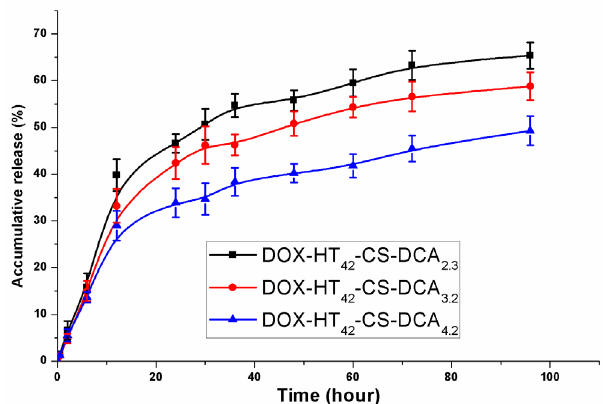
Figure 4. Release profile of DOX from HT 42 -CS-DCAs nanoparticles in 0.02 M PBS (pH 7.4) at 37 ◦ C. Data represent mean ± s.d. ( n = 3).